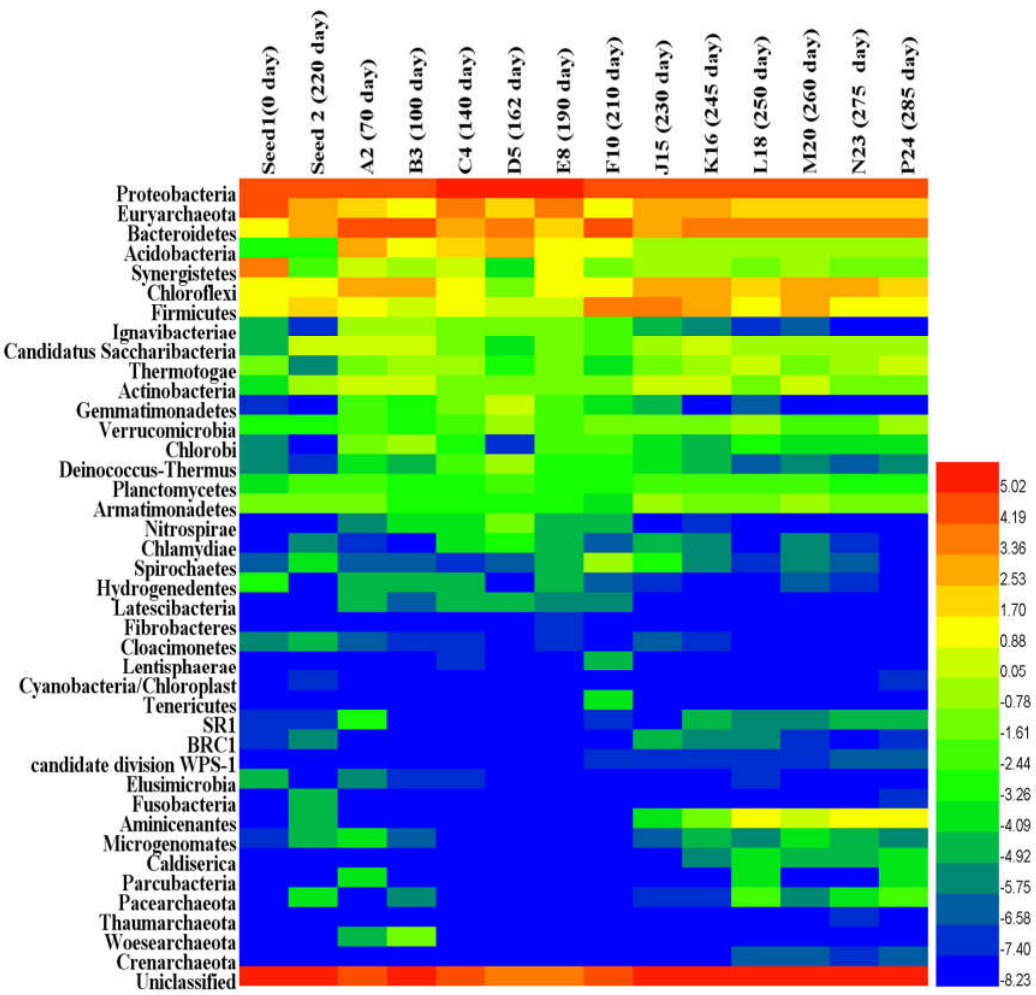
Figure 3. Heat map of the relative abundances of various phyla (>0.01%) across all 12 AnMBR and two inoculum samples (the values were log 2 transformed).